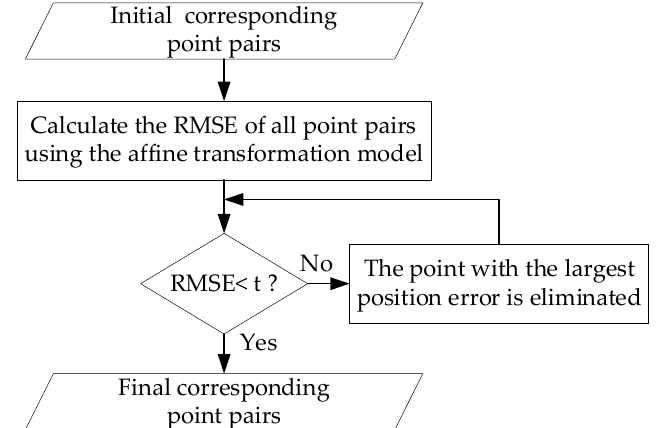
Figure 9. Non-maximum suppression results. ( a1 ) Point 1 before suppression; ( a2 ) Point 1 after suppression; ( b1 ) Point 2 before suppression; ( b2 ) Point 2 after suppression; ( c1 ) Point 3 before suppression; ( c2 ) Point 3 after suppression; ( d1 ) Point 4 before suppression; ( d2 ) Point 4 after suppression. After completing the template search and matching, the initial corresponding point pairs will be output. At this time, there may still be some mismatched point pairs in the output. Therefore, gross error elimination is still required. The gross error elimination method selected in this paper is the iterative RMSE method, and its processing flow is shown in Figure 10.